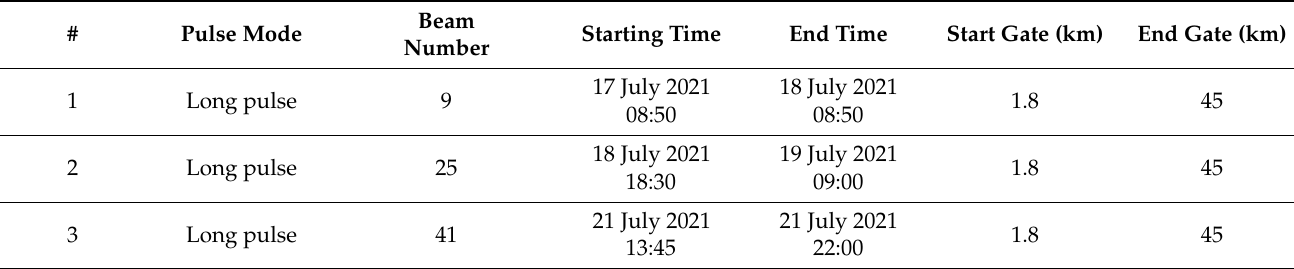
Table 1. Experimental time interval.17 July